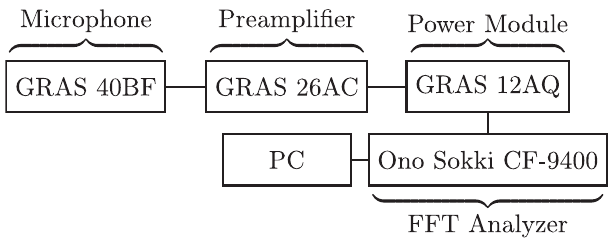
Figure 2. Schematic representation of a single channel of the electro-acoustic measuring chain for measuring the sound